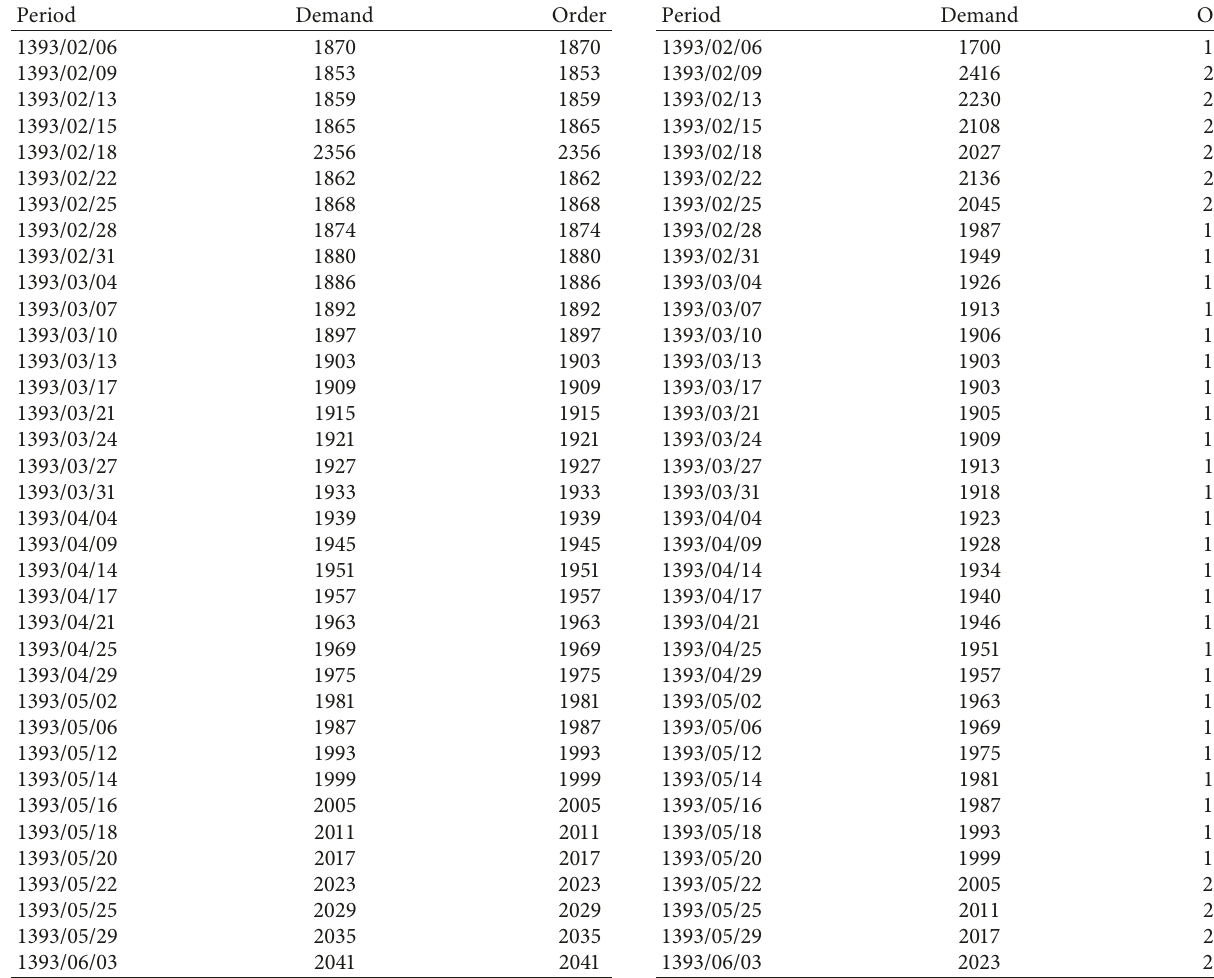
Table 13: Forecasting Zarbal Company with the moving average method.